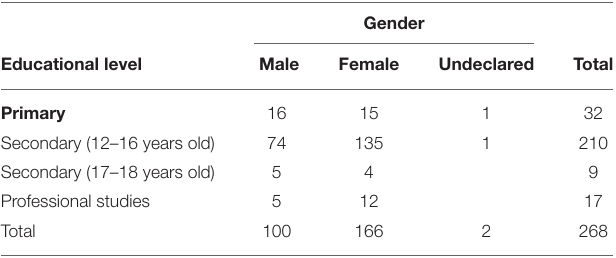
TABLE 1 | Number of students who completed the pre and post questionnaires by gender and educational